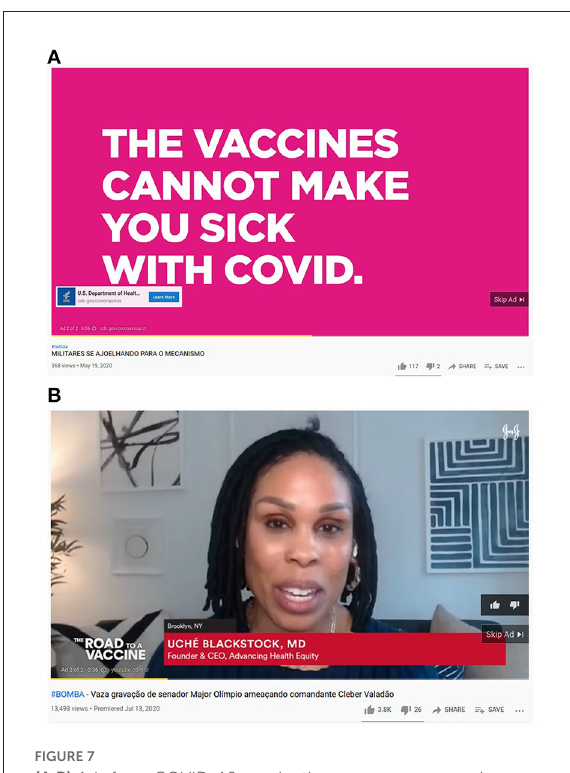
FIGURE7 (A,B) Ads from COVID-19 vaccination awareness campaigns from CDC and Johnson & Johnson playing on videos with COVID-19 M&D.